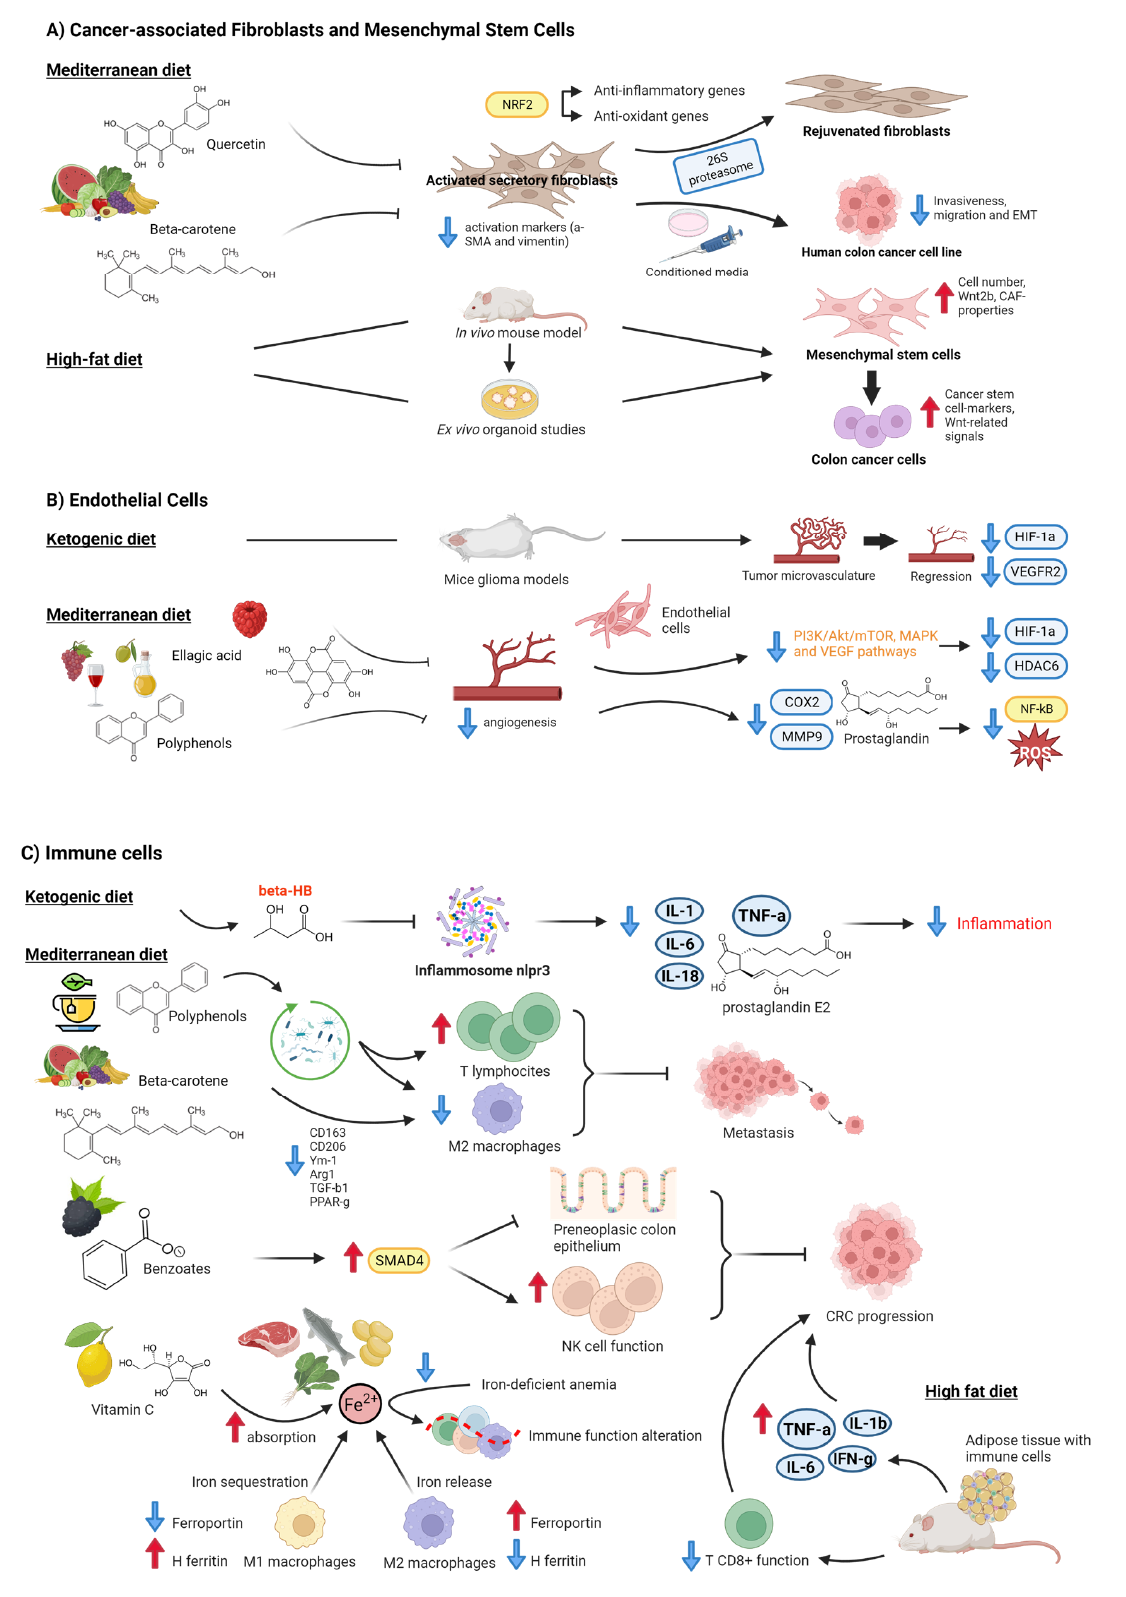
Figure 2. Effects of different diet patterns on stromal cells in colorectal cancer. ( A ) Cancer-associated Fibroblasts and Mesenchymal Stem Cells. Components of the Mediterranean Diet, such as